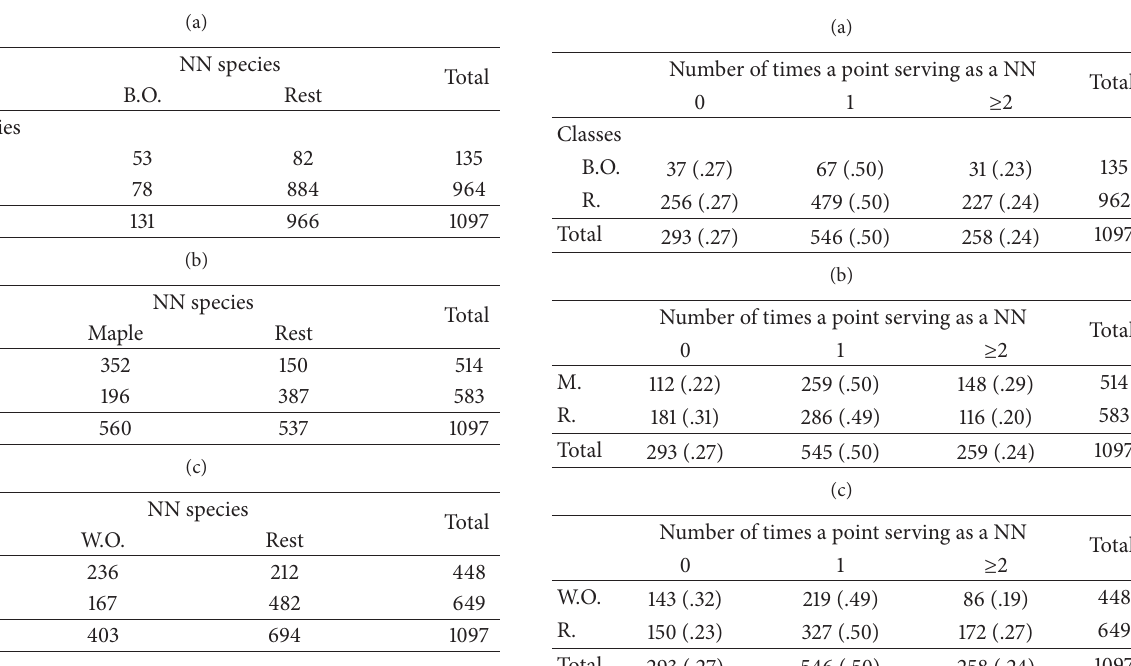
Table 20: The NNCTs for the one-versus-rest type of symmetry analysis for the Lansing Woods data (i.e., the species in question is taken as class 1 and the others combined is treated as class 2). B.O. stands for black oaks and W.O. for white oak.